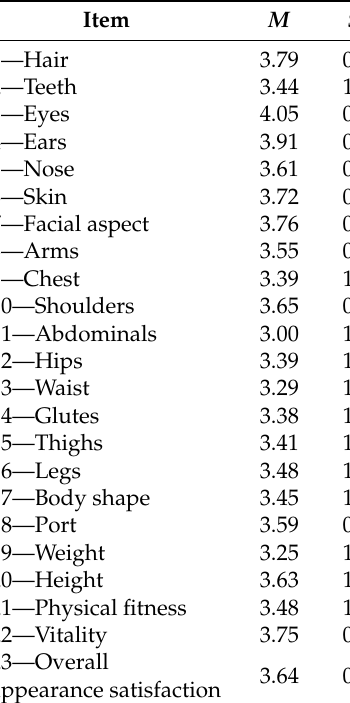
Table 2. Descriptive statistics of each item and geomin loadings of the five-factor EFA